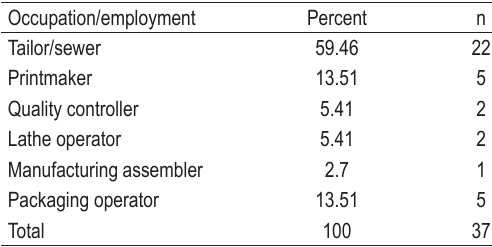
TABLE 4. Occupation/employment within a